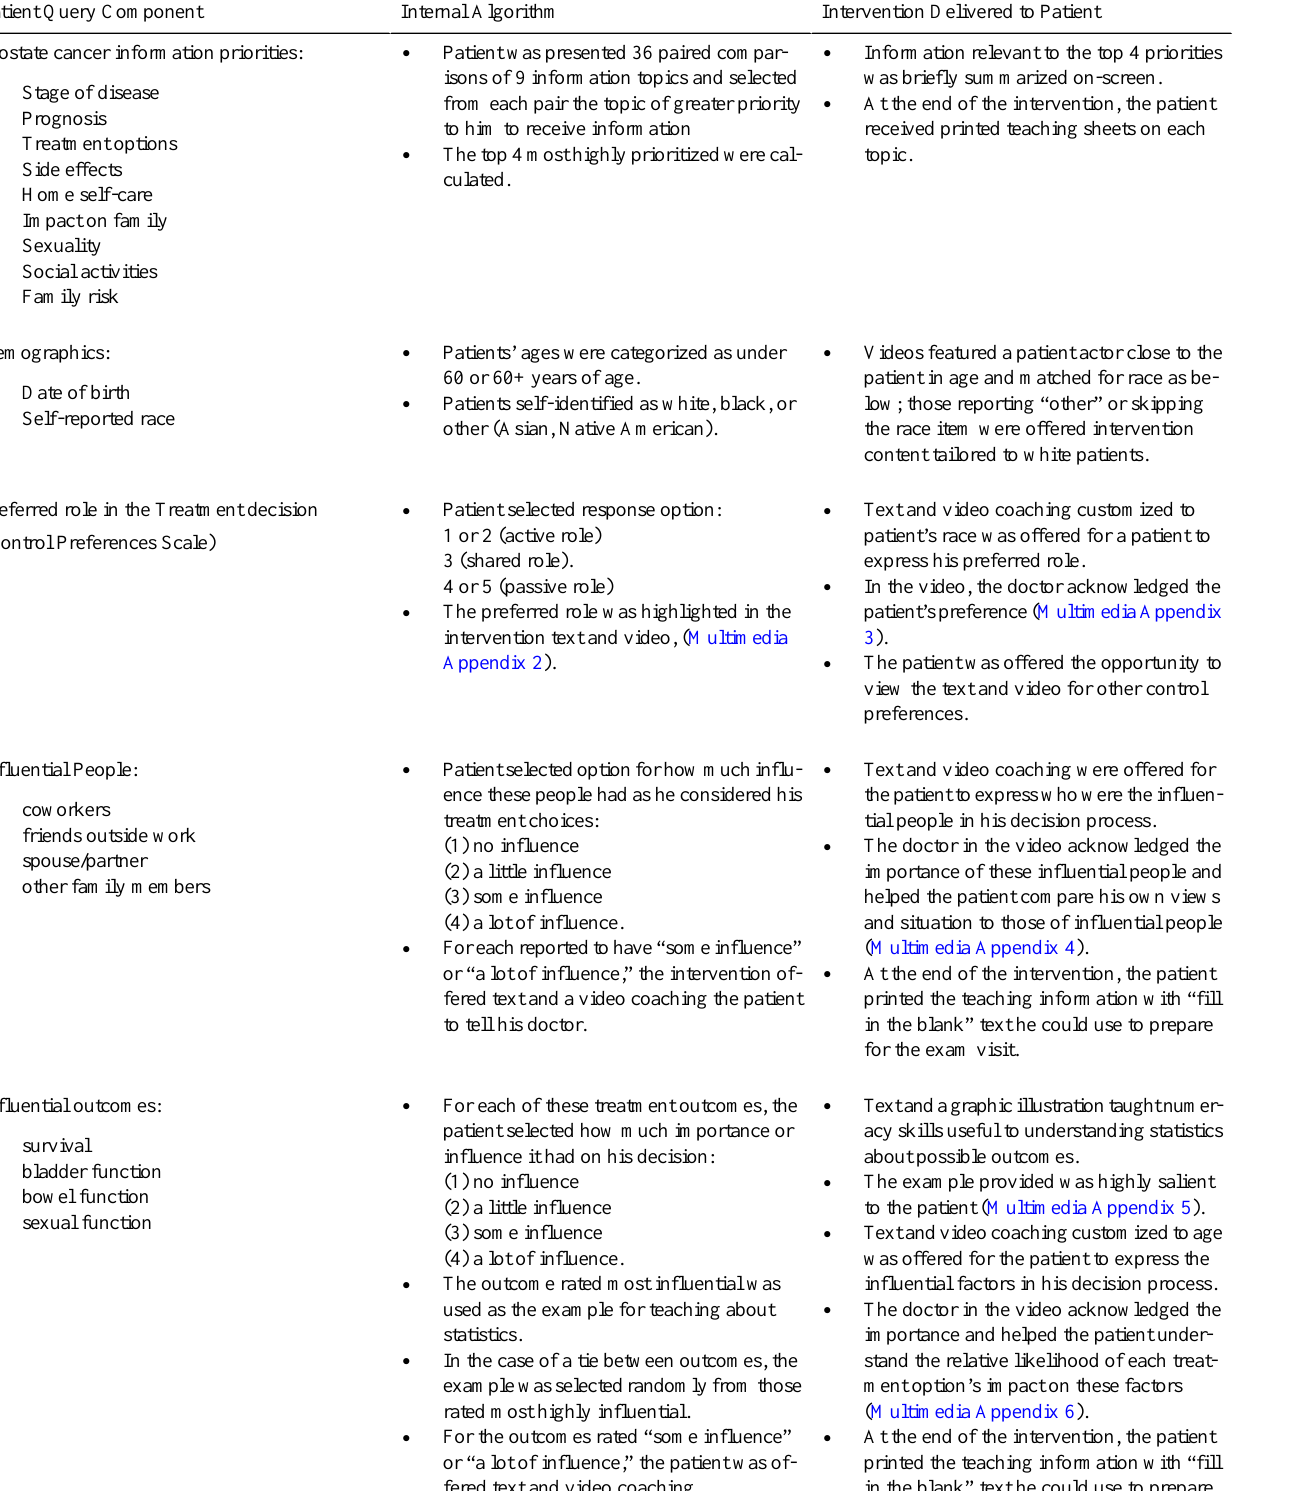
Table 2. P3P intervention customization by the patient’s personal profile Prostate cancer information